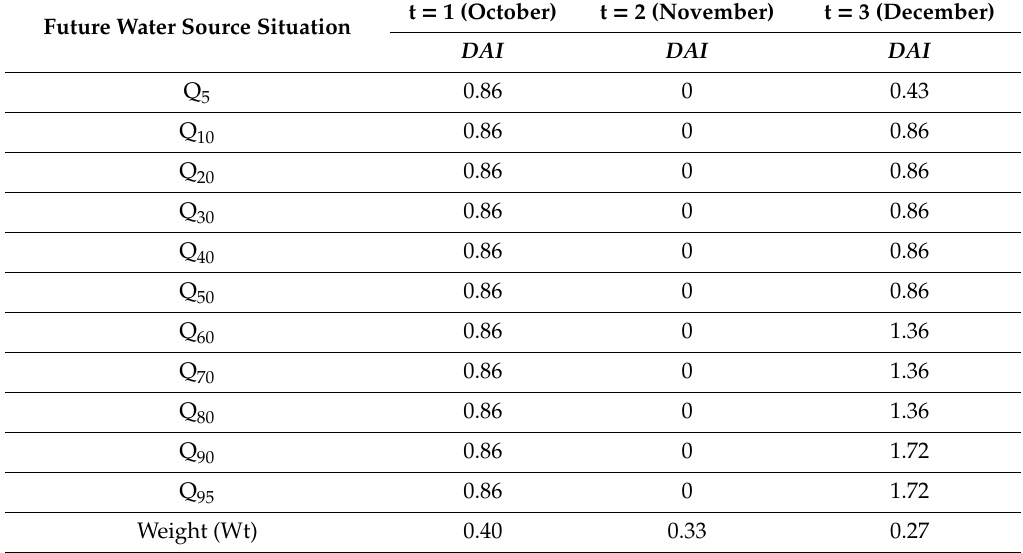
Table 16. Water supply analysis in the Irrigation Area for the three future months from September 2013 (T =